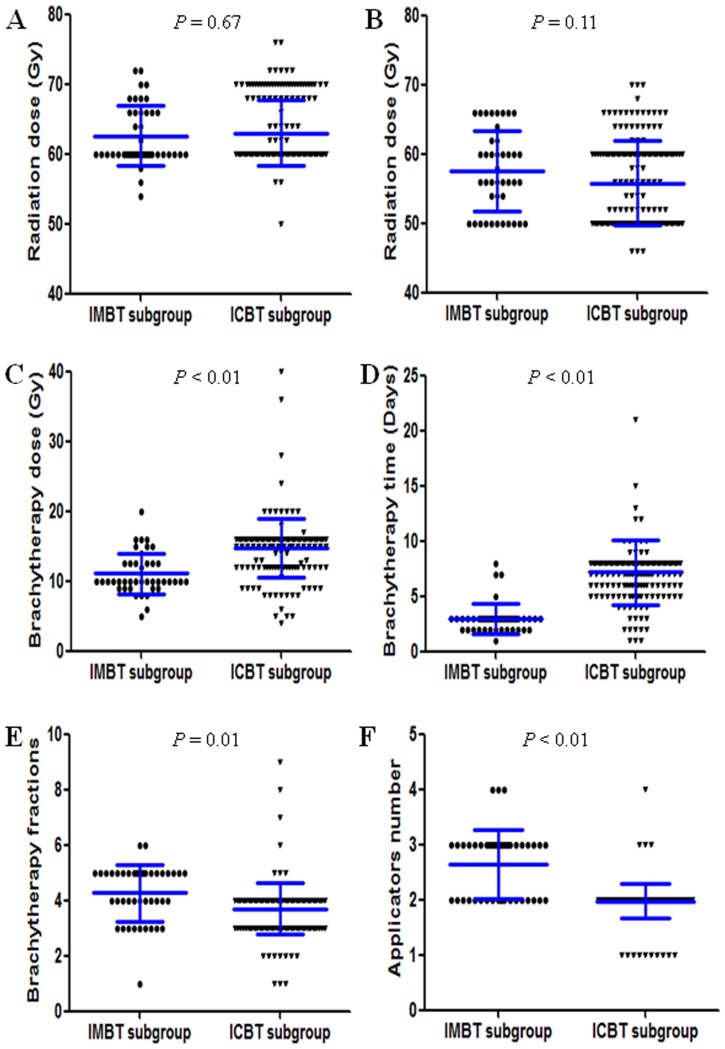
Brachytherapy related factors were compared in IMBT and ICBT boost subgroups.The external-beam radiotherapy doses in nasopharyngeal (A) and neck (B) zone were compared in IMBT and ICBT boost subgroups. The brachytherapy radiation dose (C), duration (D), fractions numbers (E) and applicator numbers (F) were compared in IMBT and ICBT boost subgroups.